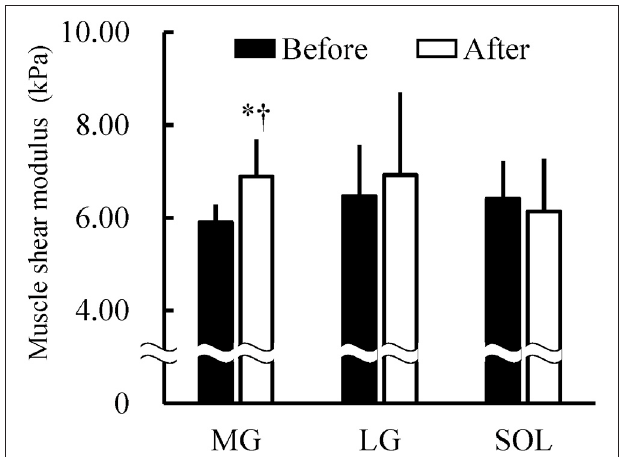
FIGURE 5 | Shear moduli of the medial and lateral gastrocnemius muscles (MG and LG) and the soleus muscle (SOL) before and after the 1-h fatiguing task ( n = 16). A two-way analysis of variance revealed that there were a significant main effect of muscle and a significant time × muscle interaction. *Indicates a significant difference before and after the fatiguing task ( P < 0.05). † Indicates a significant difference between MG and SOL ( P < 0.05).